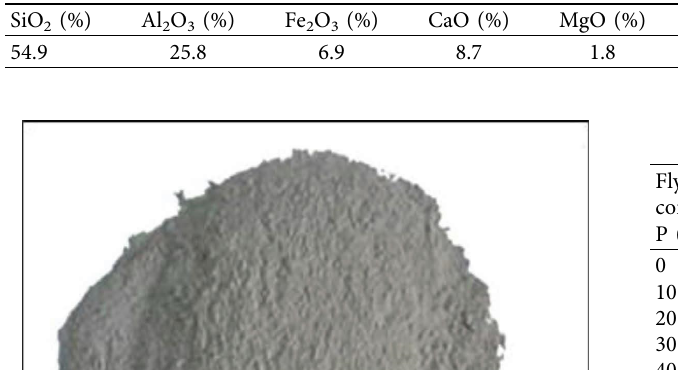
Table 2: Chemical composition of fy ash.